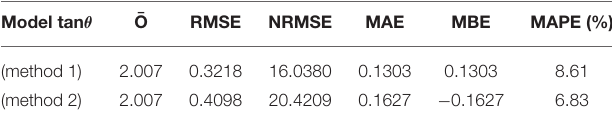
TABLE 2 | Error statistics for maximum flame height power-law correlations using method 1, ˙ Q max obtained from ˙ m max and method 2, ˙ Q max obtained from ˙ m t H (n = 18). max (cid:1) (cid:0)